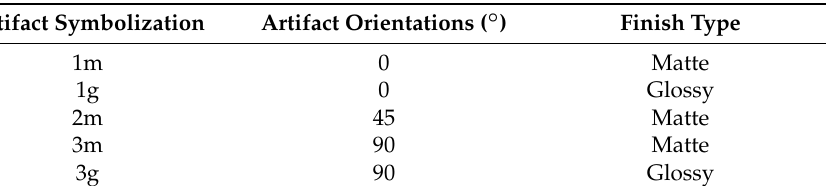
Table 4. Printed artifact symbolization.